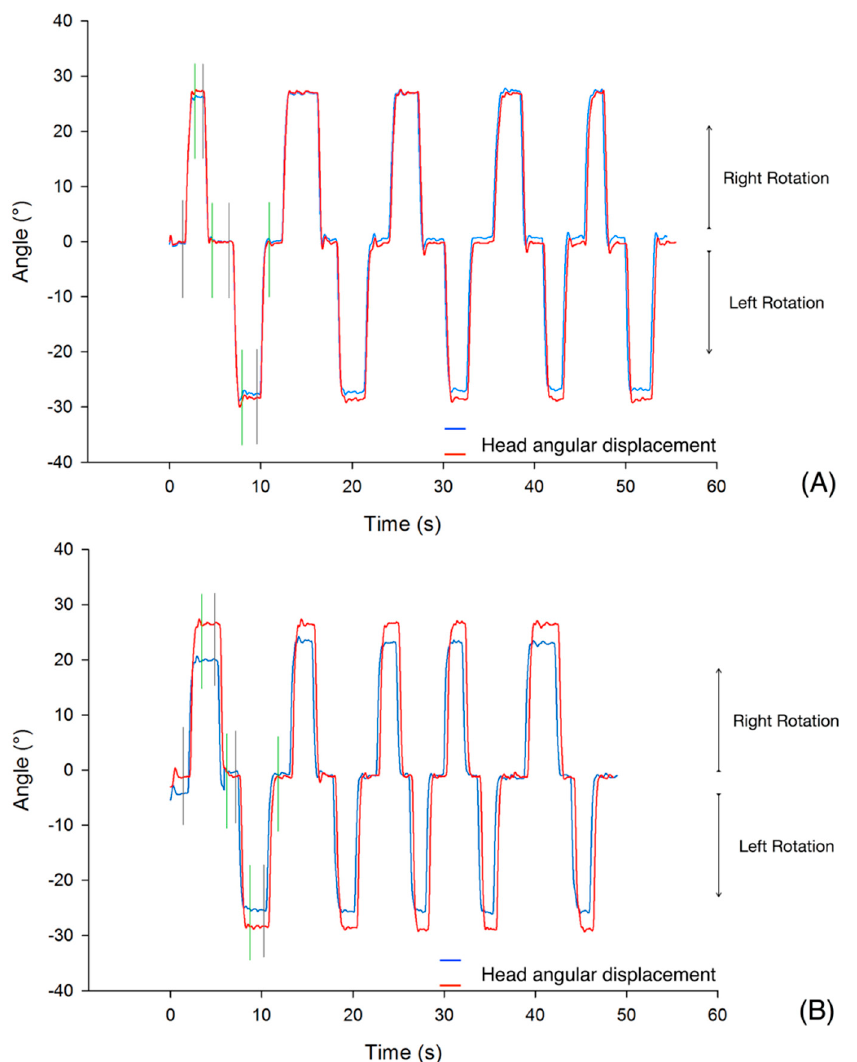
Figure 7. Typical traces of the head motion during the 5 cycles of the DidRen Laser Test showing comparison of Elite (red line) and DYSKIMOT (Blue line) angle discrepancies. In ( A ), the best angle agreement between Elite and DYSKIMOT (difference = 0.6°, mean angle during 5 cycles = 25.7°) in an DP (34 years, male, NDI=22, NPRS = 5), and in ( B ) the worst agreement (difference = 4.0°, mean angle during 5 cycles = 27.5°) in a NDP (22 years, male, NDI = 0, NPRS = 0). Cursors indicating the beginning (grey) and end (green) of one axial rotation movement are shown.